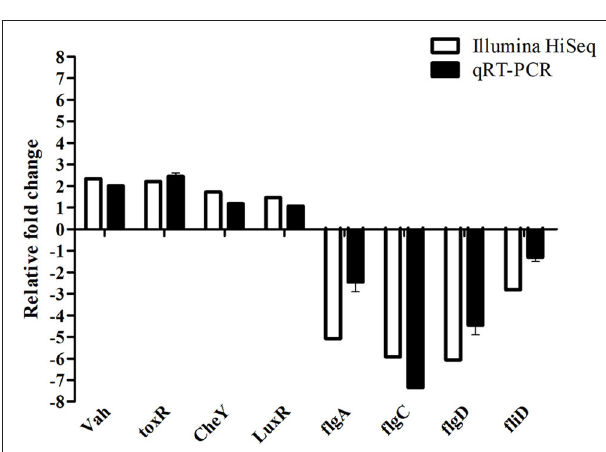
FIGURE 7 | Comparative analysis of qRT-PCR and transcriptome sequencing result of differentially expressed genes of V. anguillarum before and after starvation